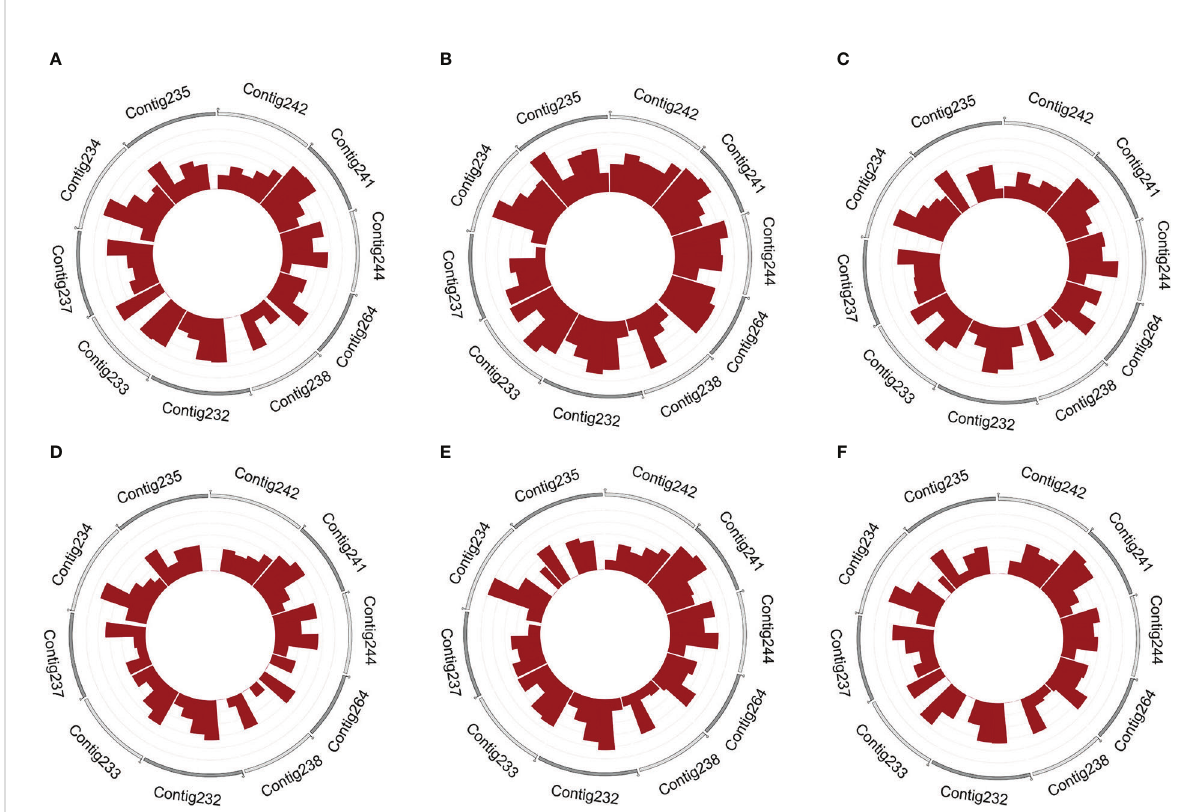
FIGURE 1 The density of circRNAs in female and male fl ower buds on different contigs. The 10 most densi fi ed distributed contigs in female and (A – C) and male (D – F) fl ower buds, respectively. The outer ring takes 10 contigs for display. A contig with more rings has a higher density of